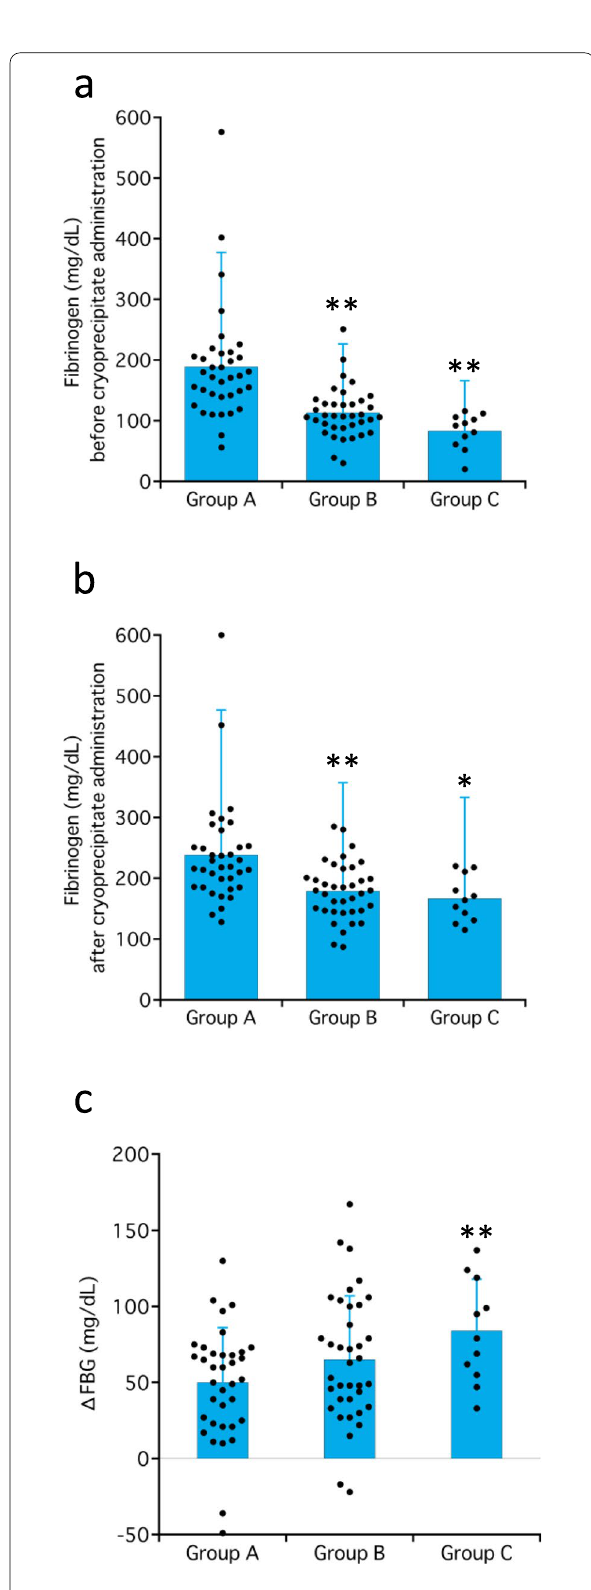
Fig. 1 Fibrinogen levels before ( a ) and after ( b ) the administration of cryoprecipitate and their degrees of increase ( c ). The fibrinogen levels were significantly lower in groups B and C than in group A before the administration of cryoprecipitate ( a ). They significantly increased in all groups after the administration of cryoprecipitate ( b ), although they were still significantly lower in groups B and C than in group A after the administration of cryoprecipitate. However, the degree of increase in the fibrinogen level was significantly greater in group C than in group A ( c ). * p < 0.05 and ** p < 0.01 vs. Group